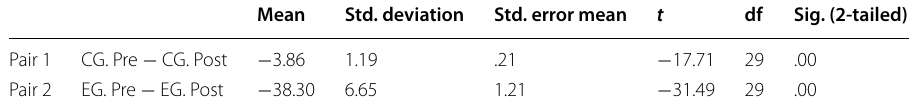
Table 20 Paired samples test (anxiety pre‑ and post‑tests of each group) Mean Std. deviation Std. error mean Pair 1